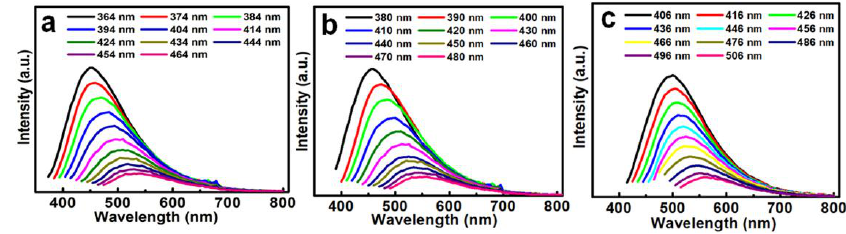
Figure 4. Excitation-dependent PL behaviors of ( a ) CQDs-90, ( b ) CQDs-120, and ( c ) CQDs-150.